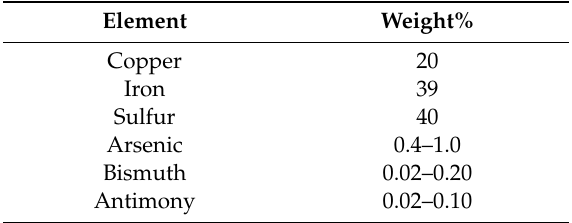
Table 1. Feed compositions entering the smelting furnace.